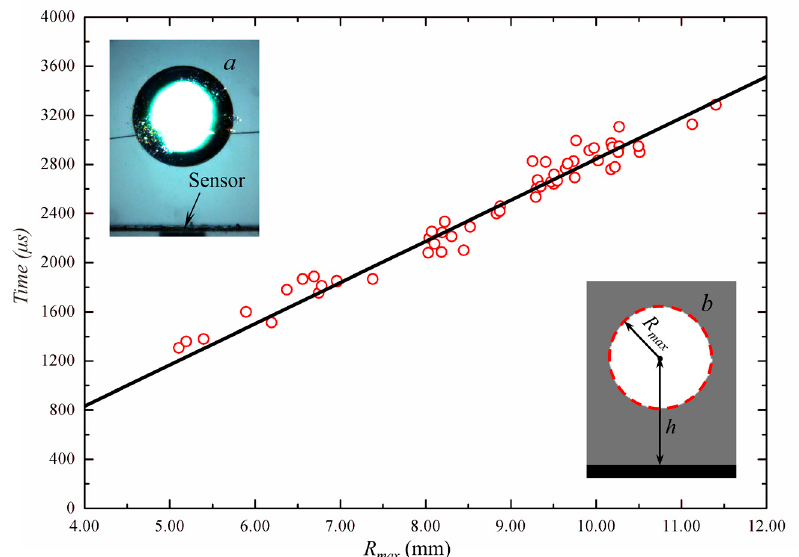
Figure 2. Processing method of characteristic parameters. ( a ) Cavitation bubble photograph; ( b ) characteristic parameters.